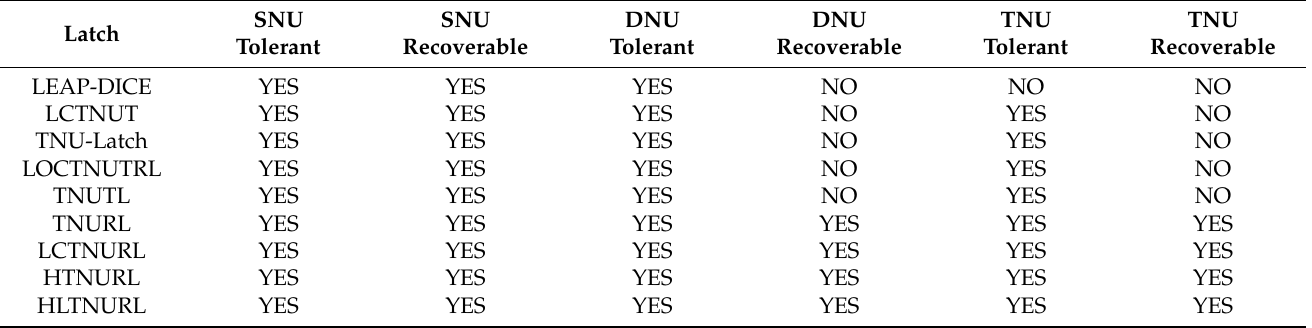
Table 1. Robustness comparisons between the existing TNU latches and proposed HLTNURL latch.